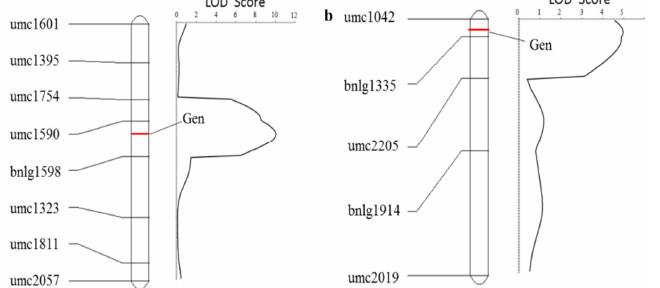
Figure 6. QTL results of tassel symptoms of maize infected with Sporisorium reilianum in two F 2 populations. ( a ) QTL of tassel symptoms of maize infected with Sporisorium reilianum between Huangzao4 and Jing7. ( b ) QTL of tassel symptoms of maize infected with Sporisorium reilianum be ‐ tween Jing7 and Chang7 ‐ 2.